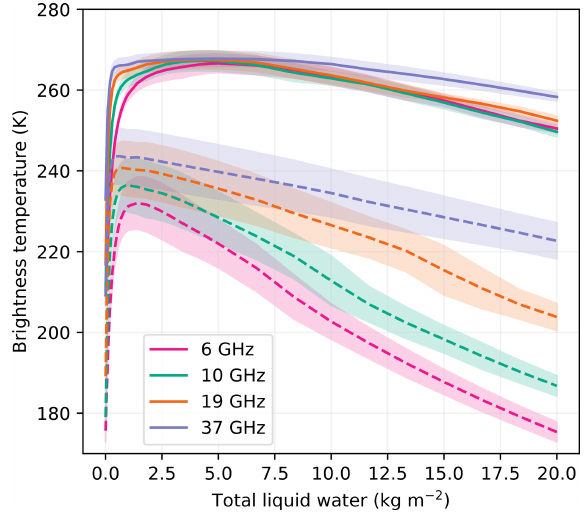
Figure 6. Brightness temperatures at Roi Baudouin obtained with the 1000 best (i.e., most probable) snowpacks as a function of the total liquid water content for four frequencies at V-pol (solid curves) and H-pol (dashed curves). The lines show the mean brightness tem- perature of the ensemble, and the shade areas materialize ± 1 stan- dard deviation around the